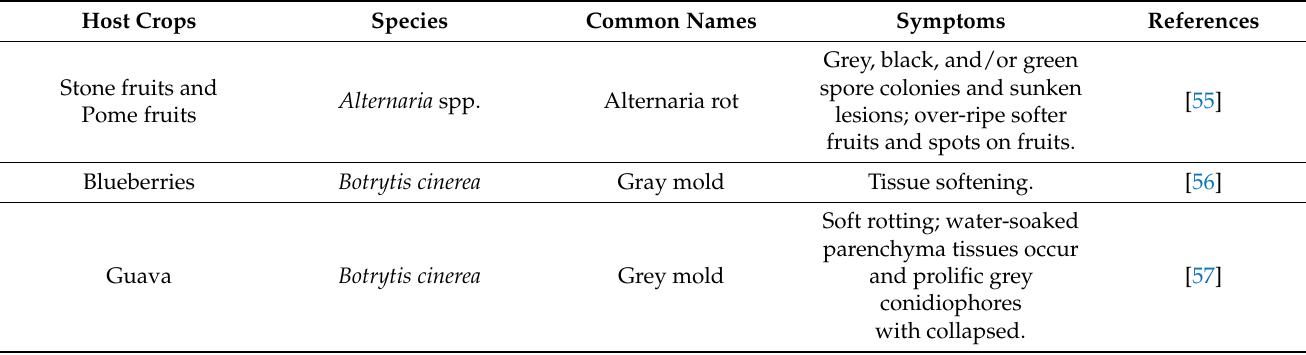
Table 1. Fruits with postharvest fungal infection.